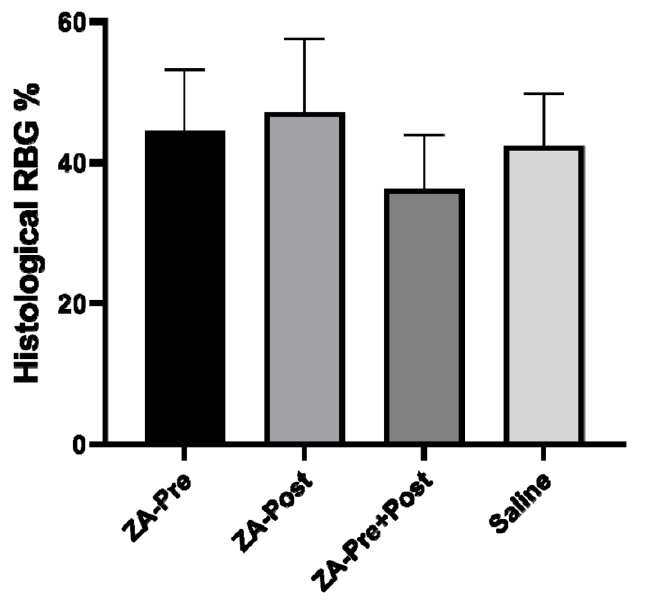
Figure 5. Bar graph with standard deviation indicating the mean quantitative histomorphometric values of remaining bone graft percentage (RBG%) for the different study groups.